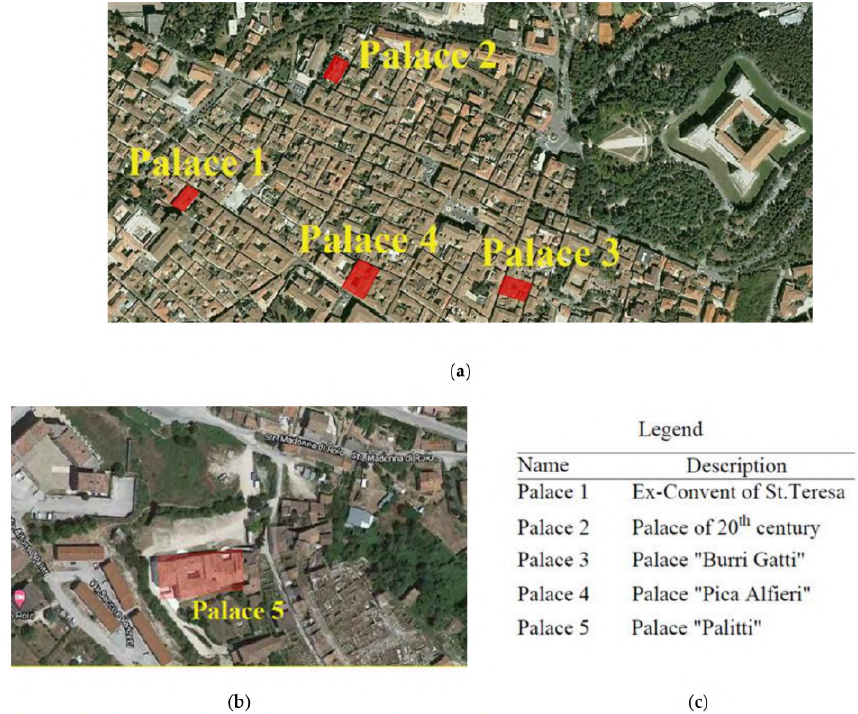
Figure 6. ( a ) Location of 4 palaces in the historical center of L’Aquila; ( b ) location of the 5th palace in the district near the historical center (from Google Earth); ( c ) legend of the